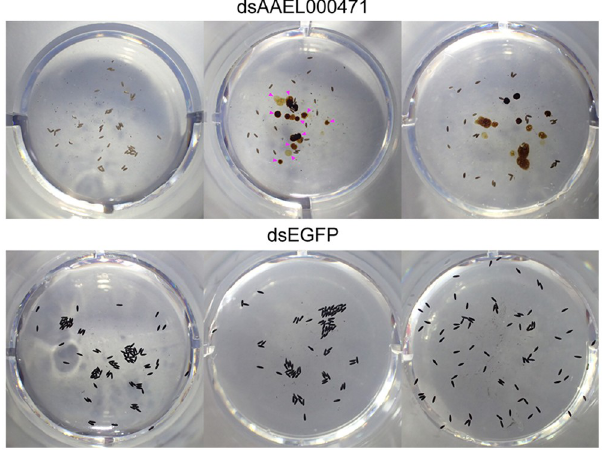
Fig 6. AAEL000471-silenced mosquitoes exhibited small, pale-colored eggs and delayed excretion. Representative EAgaL assay wells after individual females were placed in each well for 48 h (72–120 hPBM). Females injected with dsRNA against AAEL000471 laid small (short), pale-colored eggs and exhibited delayed excretion (magenta arrowheads in the top middle panel). https://doi.org/10.1371/journal.pntd.0009334.g006 Sequence and phylogenetic analysis of dyspepsia . Dysp is predicted to encode a 689 amino-acid polypeptide with 12 predicted transmembrane domains (TMD) [27], and a long cytoplasmic loop between TMD 6 and 7 (S2 Fig), which shows sequence similarity to the solute carrier 16 (SLC16) transporter family. Alignment with human SLC16 proteins indicated that the long cytoplasmic loop is only present in dysp (S3 Fig). To better establish the relationship of dysp with the SLC16 proteins, only some of whom have characterized substrates, we per- formed a phylogenetic comparison between homologs identified in dipterans D . melanogaster (fruit fly) and An . gambiae (African malaria mosquito), as well as the zebrafish D . rerio and the budding yeast S . cerevisiae (Fig 8). Most vertebrate SLC16 genes clustered in the distal clades, whereas dipteran SCL16 genes clustered in the basal clades. This suggests that most of the dip- teran SLC16 genes could have evolved independently from their vertebrate counterparts, pre- sumably for specific functions. dysp was found to cluster together with a single ortholog in An .